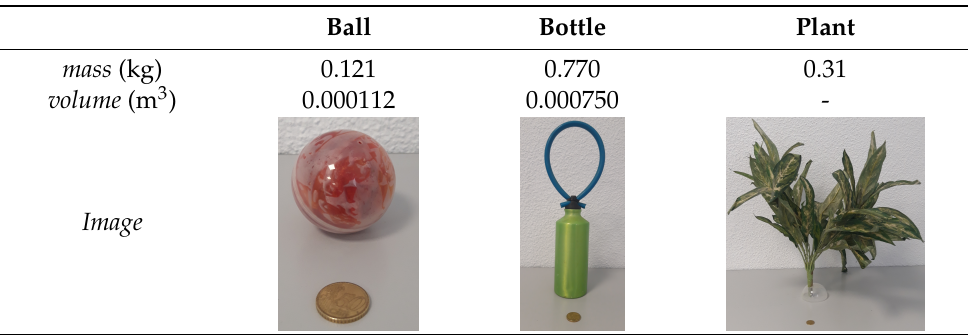
Table 1. Physical properties of the submerged objects used for the